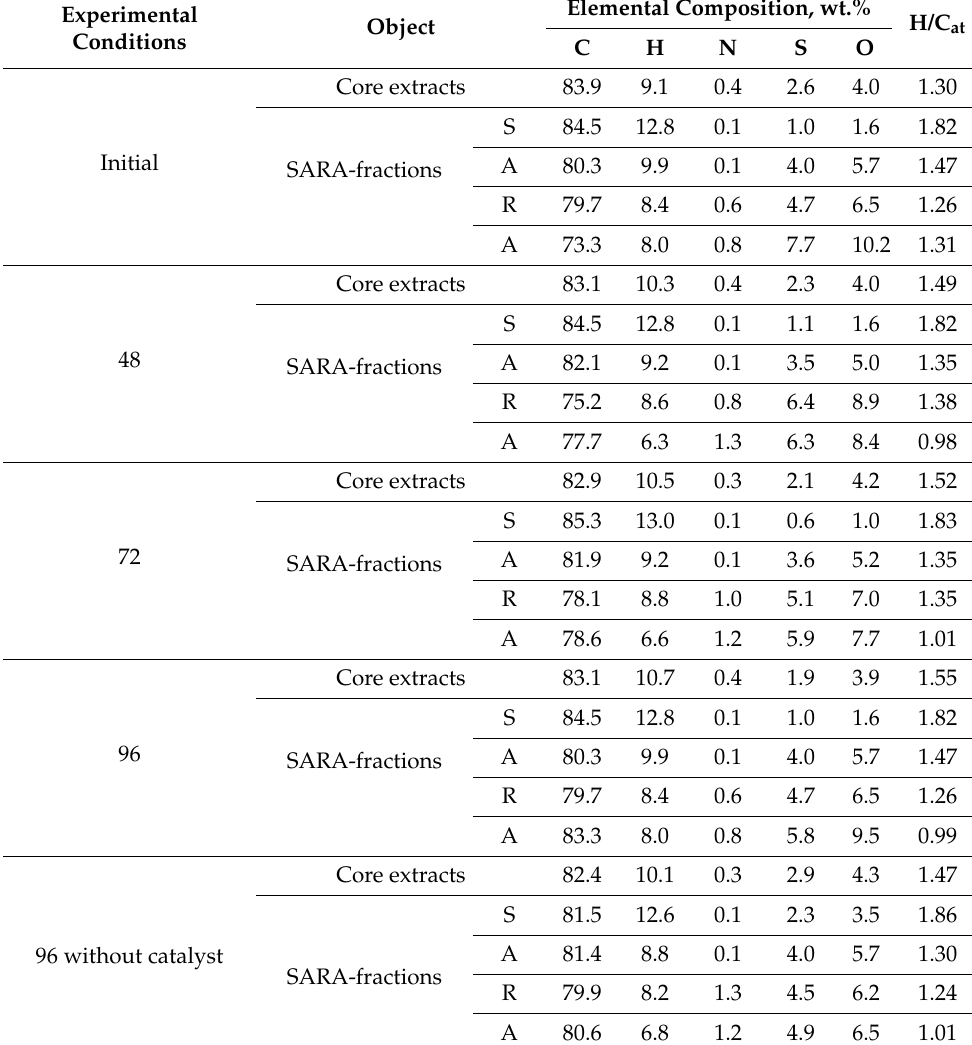
Table 5. Elemental composition of core extracts and SARA